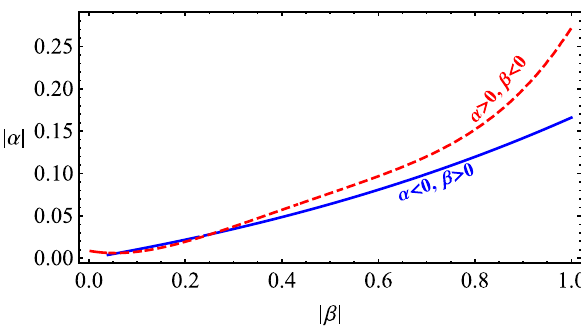
Fig. 12 The dependence of the ISCO radius of test particles on spin of Kerr BH and MOG parameter. Red-dashed, blue-dashed, black-solid andgray-dotdashedlinesarecorrespondtotheISCOofmagnetizedpar- ticles with magnetic coupling parameters β = 0 . 5, β = − 0 . 5, neutral particles around Schwarschild-MOG and Kerr black holes, respectively